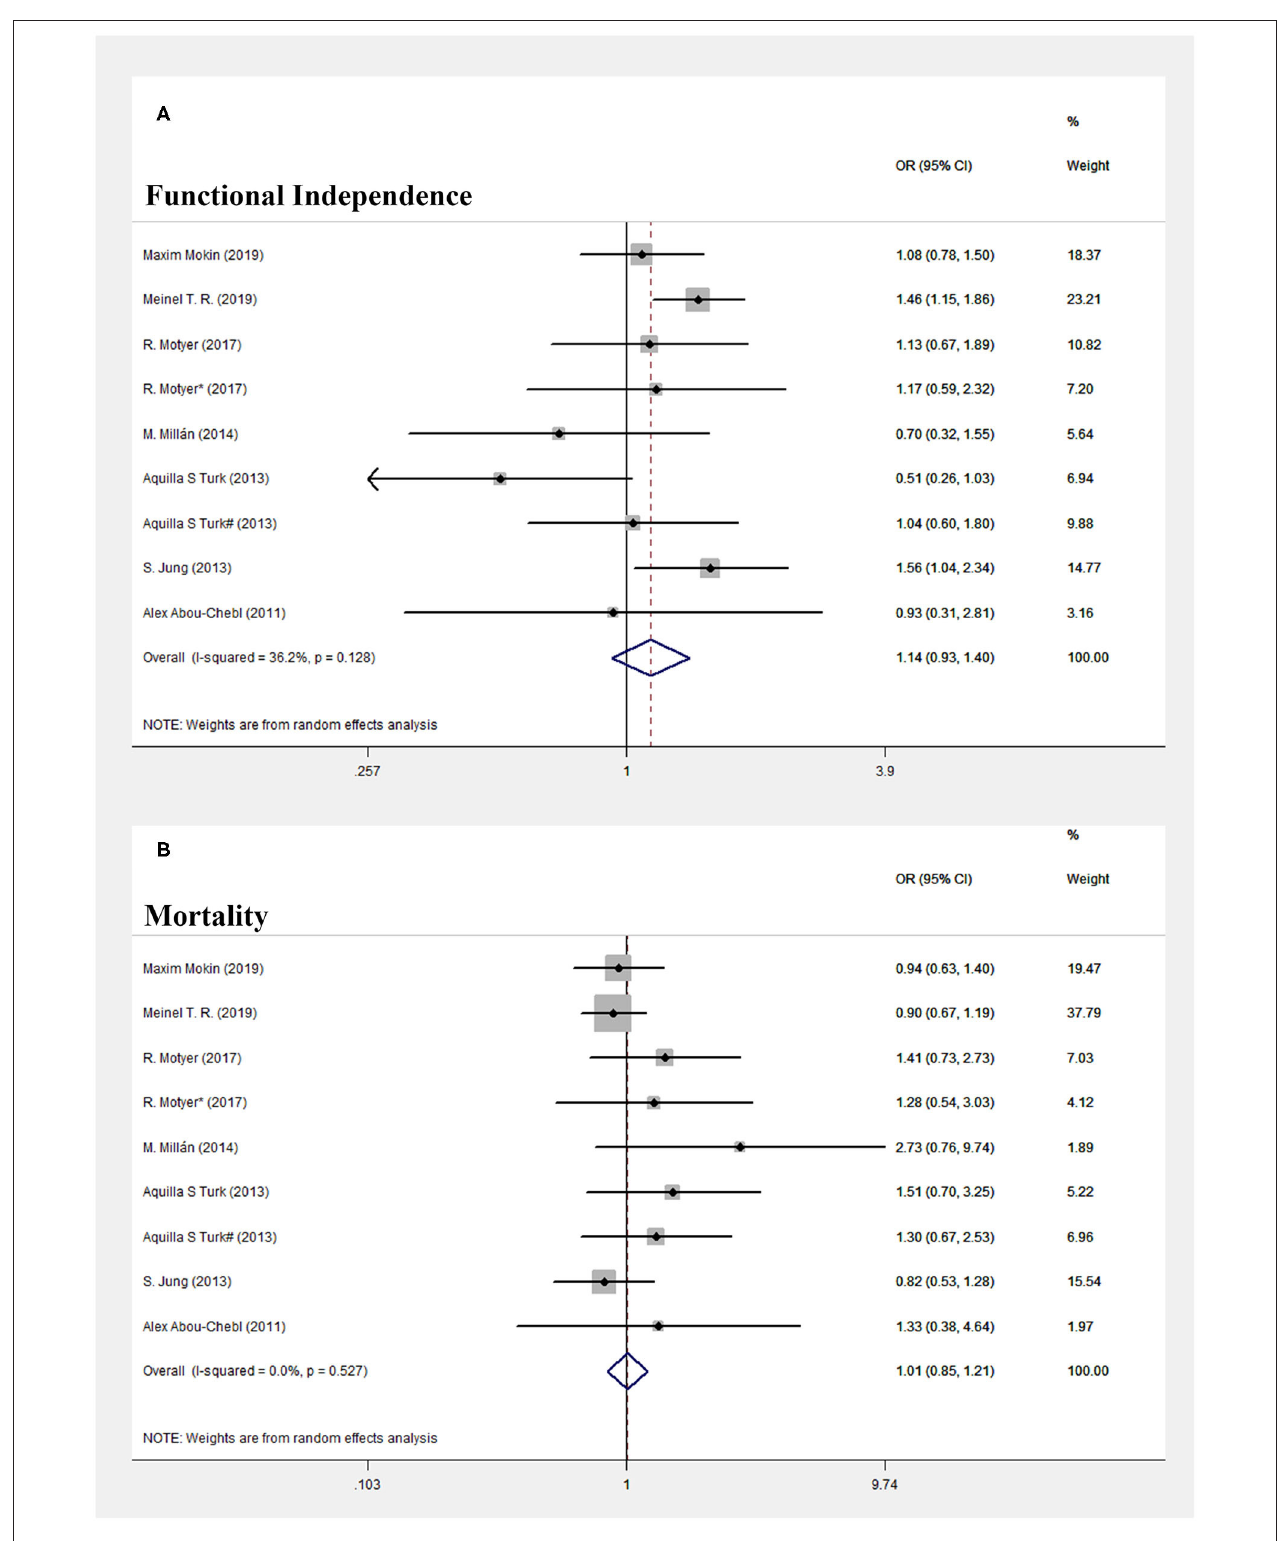
FIGURE 2 | Forest plot of comparison. (A) Functional independence. (B) Mortality.